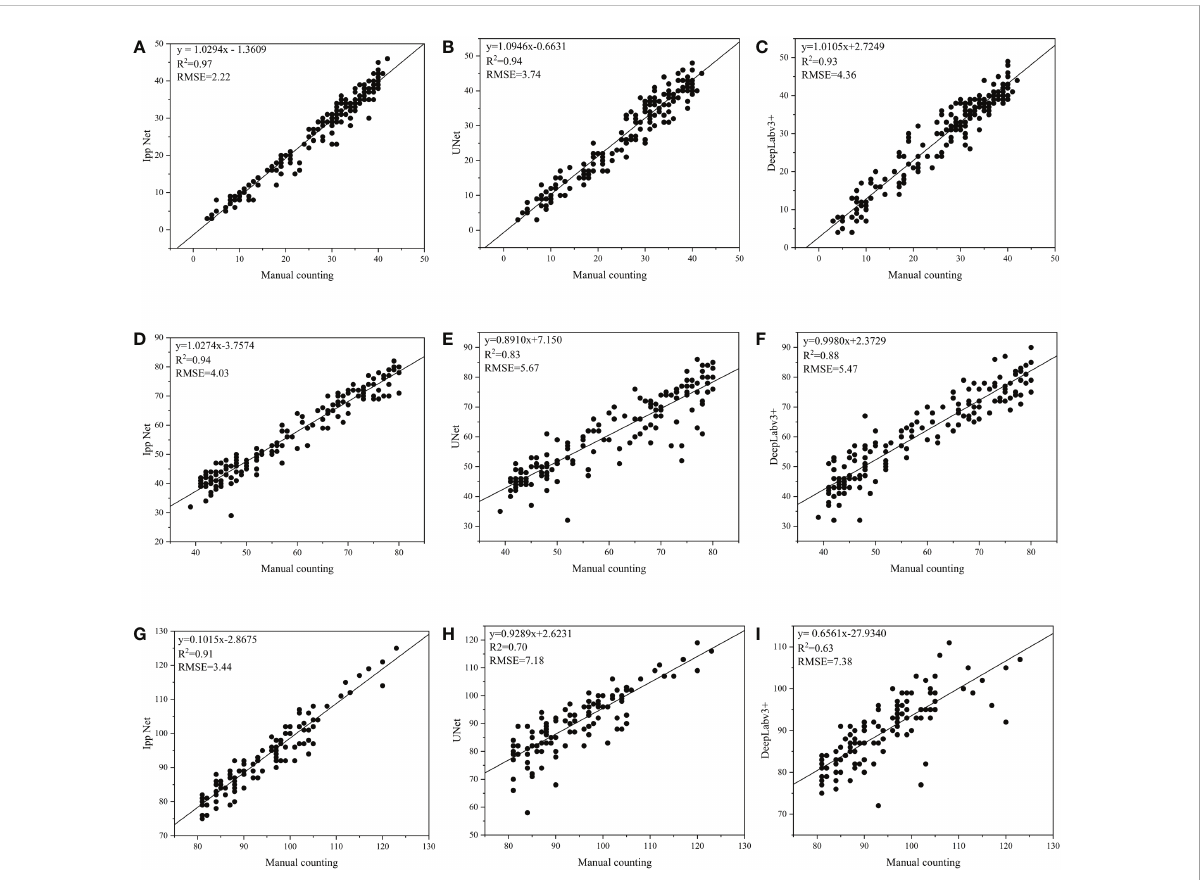
FIGURE 11 Comparison results of Ipp Net, U-Net and DeepLabv3+ with manual counting at three different densities. (A – C) : DS1, low-density; (D – F) : DS2, medium-density; (G – I) : DS3,